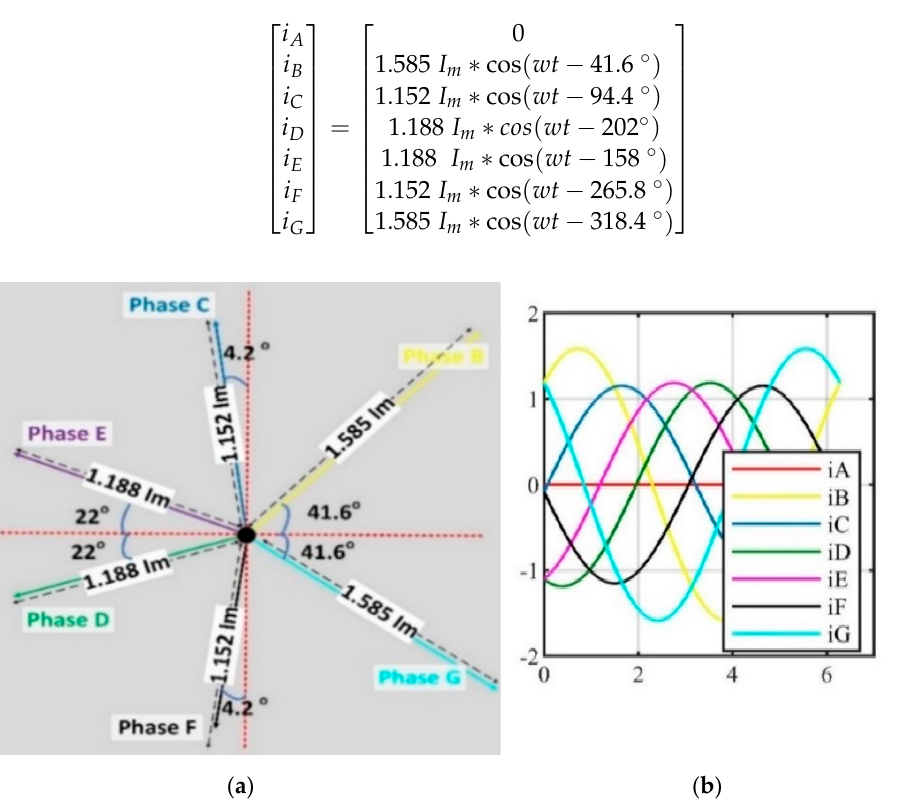
Figure 5. Current distribution of seven ‐ phase motor under minimizing torque ripple optimization. ( a ) Phasor; ( b ) sinusoidal.